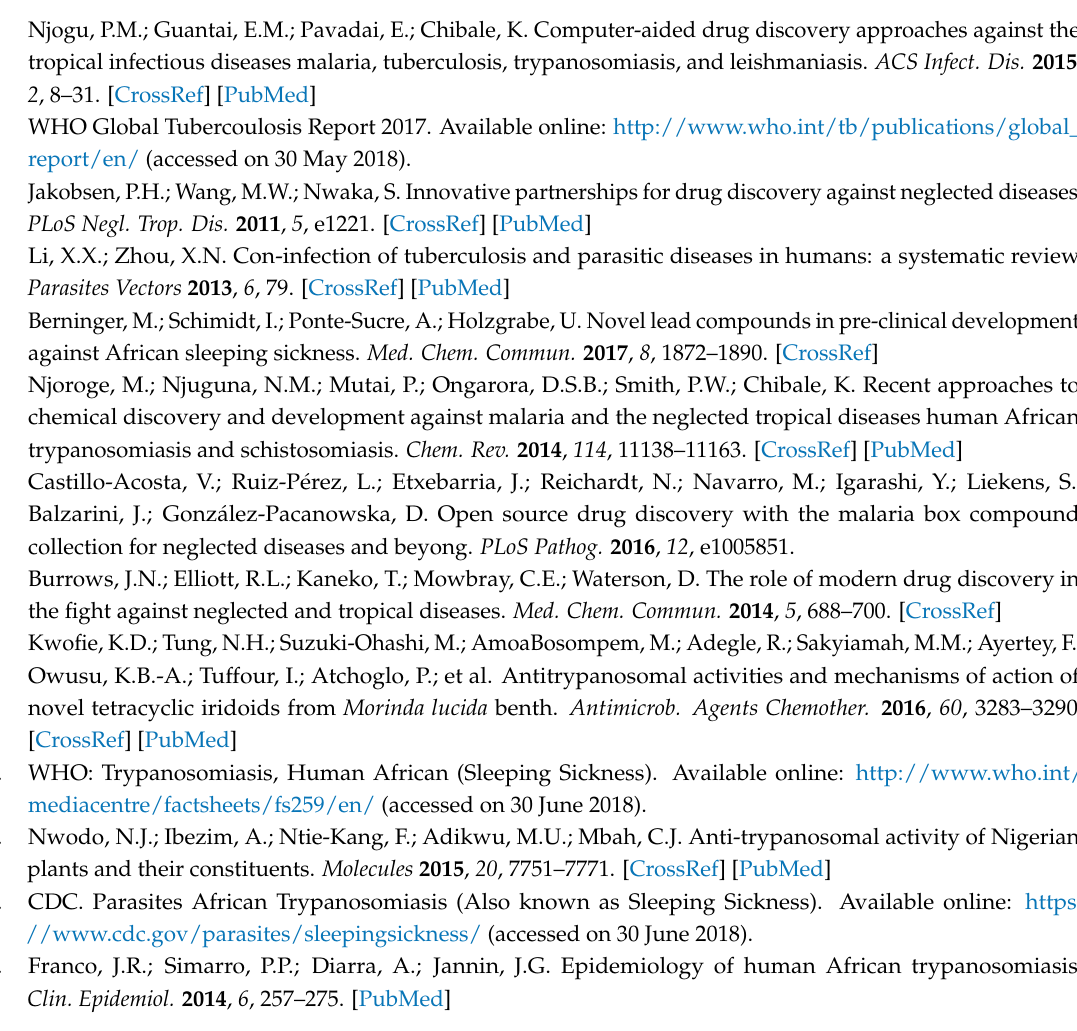
Supplementary Materials: The following are available online (Synthesis of compound 6 , 1 H and 13 C-NMR spectra of 5c , 5d , and 5g